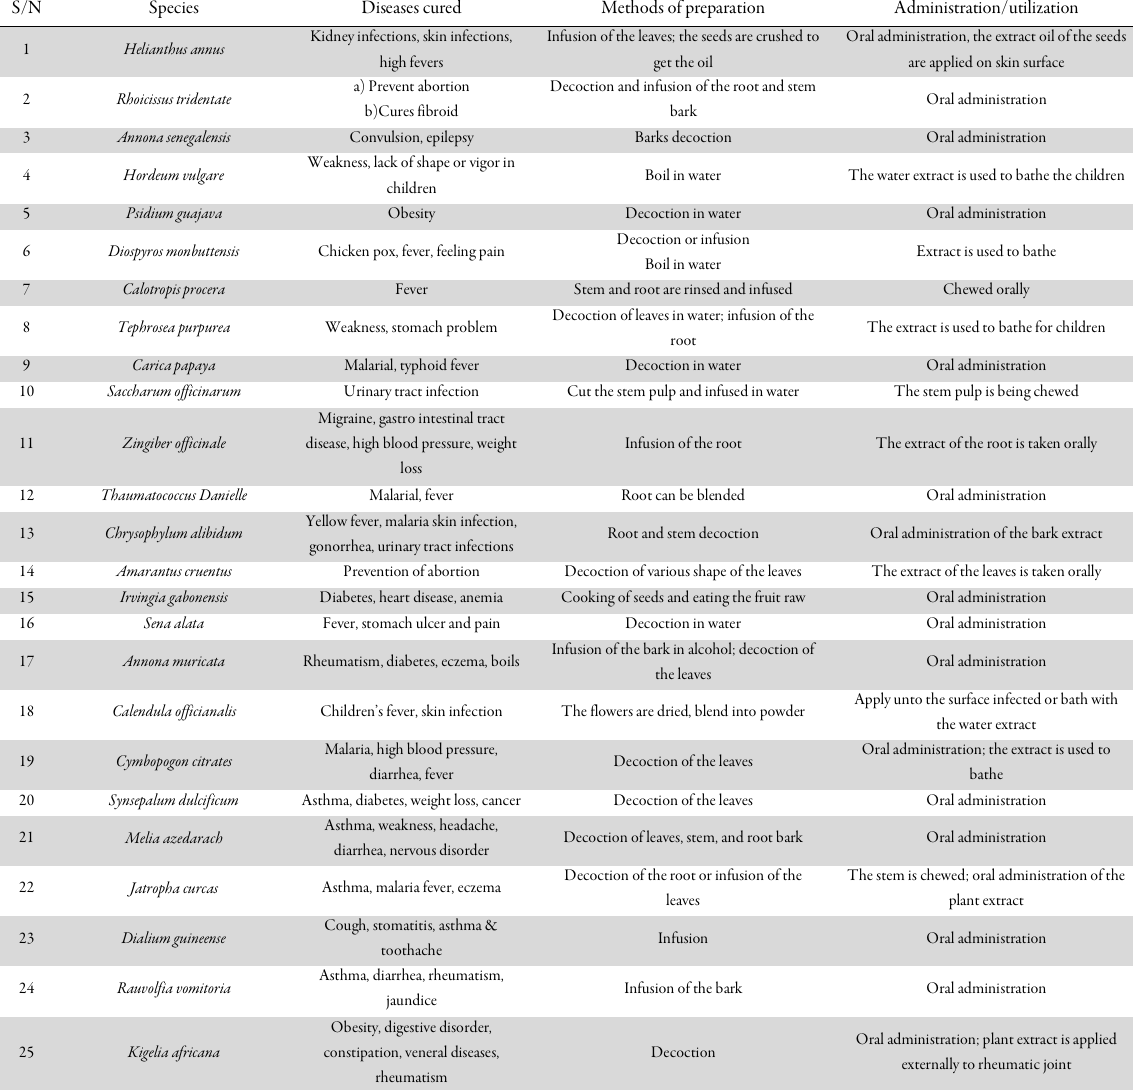
Table 5. Diseases cured, methods of preparations and utilizations of plant medicines obtainable from the identified plant species in Badagry Local Government, Lagos